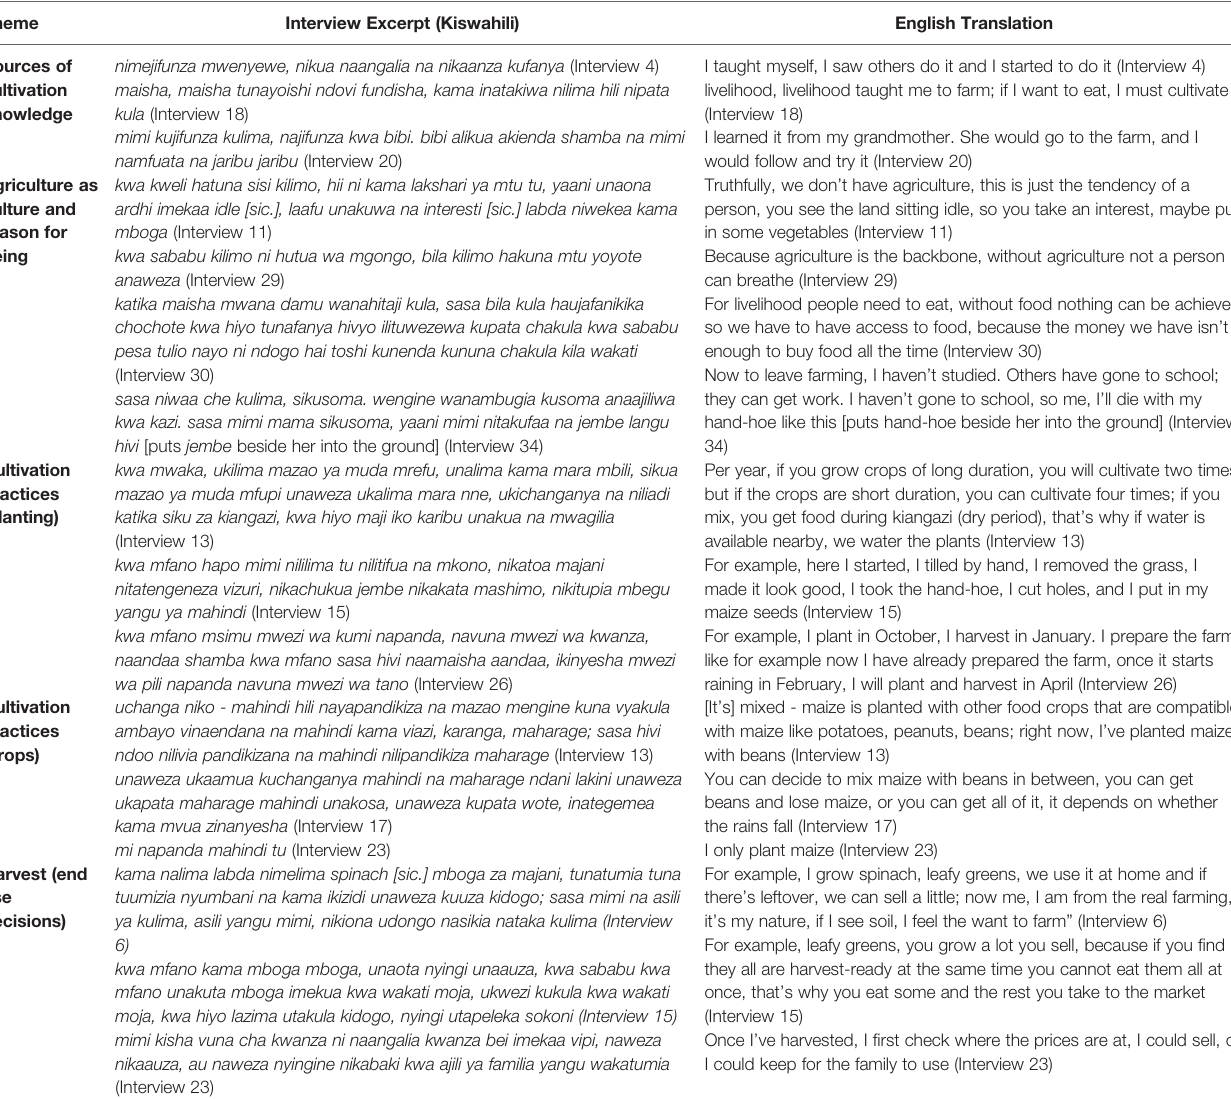
TABLE 3 | Excerpts from interviews that express urban farmers ’ motivations, constraints, and cultivation practices with respect to urban agriculture in